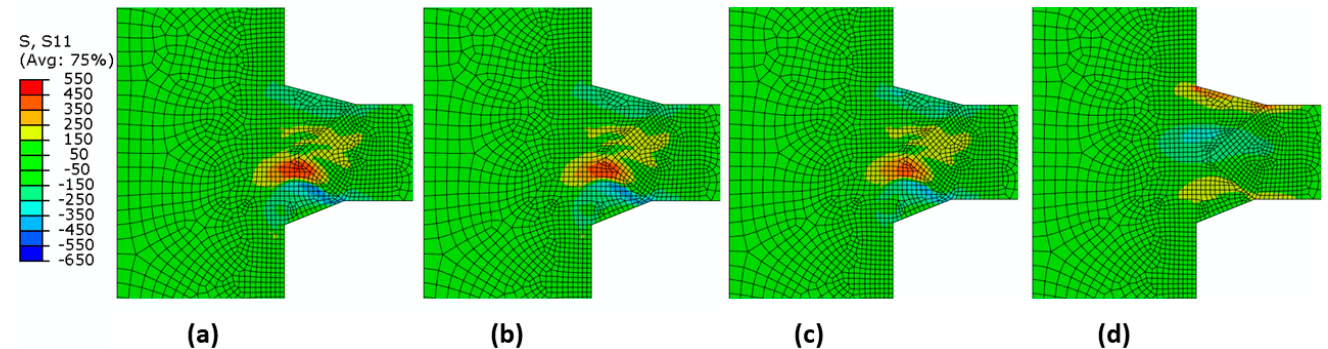
Figure 8. Normal residual stress in the FE model in different cases (MPa), (a) Ms = 300 °C, (b) Ms = 350 °C, (c) Ms = 400 °C, and (d) no phase transformation.